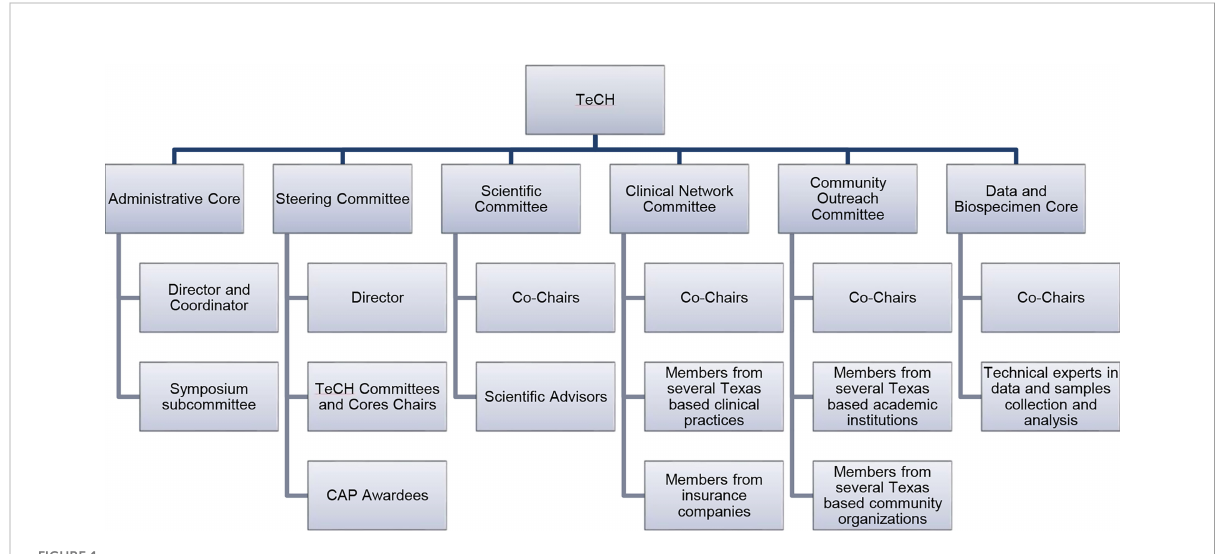
FIGURE 1 The Committees and Cores of the